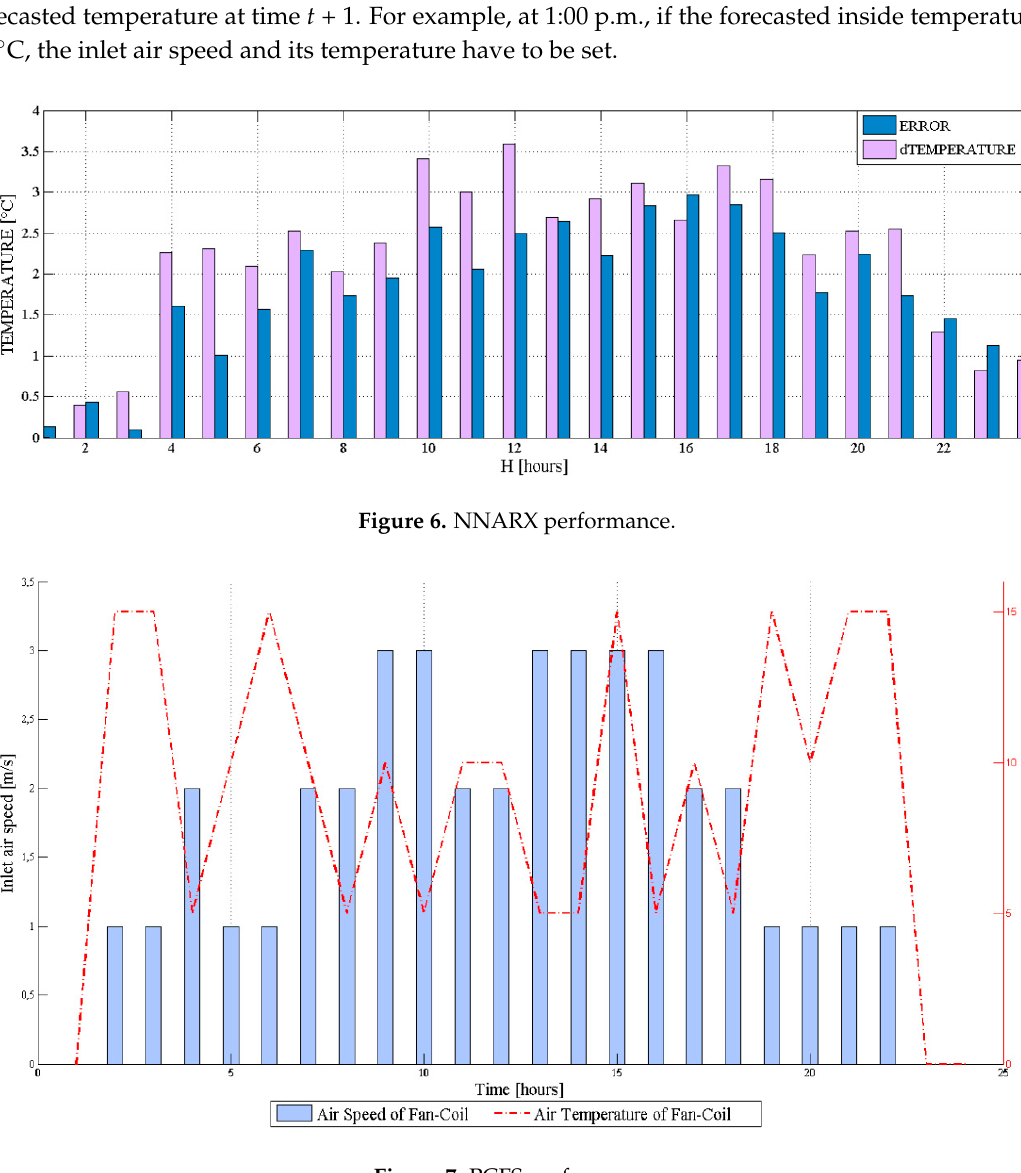
Figure 7. PCFS performance. Figure 7. PCFS